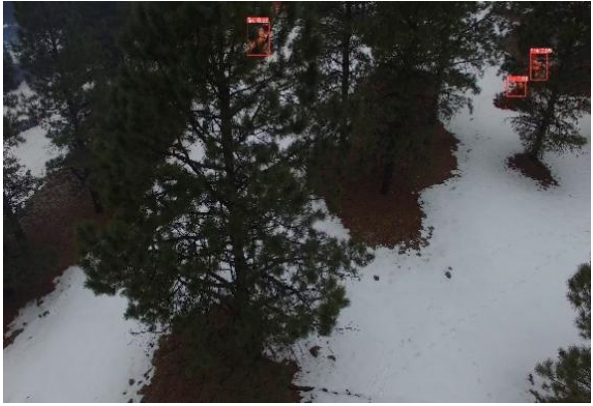
Figure 12. Detection result using STPM_SAHI on a snowy day.